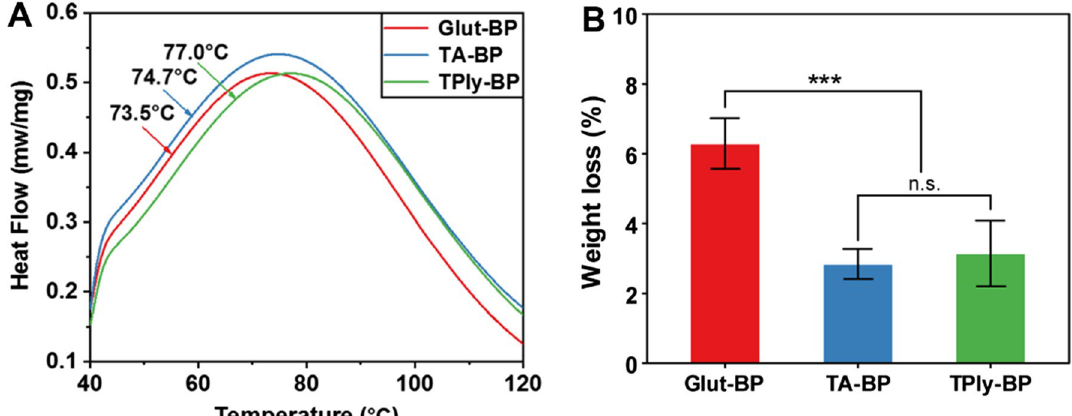
Fig. 2 Thermodynamic stability. A DSC plots for Glut-BP, TA-BP and TPly-BP. B Weight loss ratio of Glut-BP, TA-BP and TPly-BP after enzymatic degradation (n 4) =